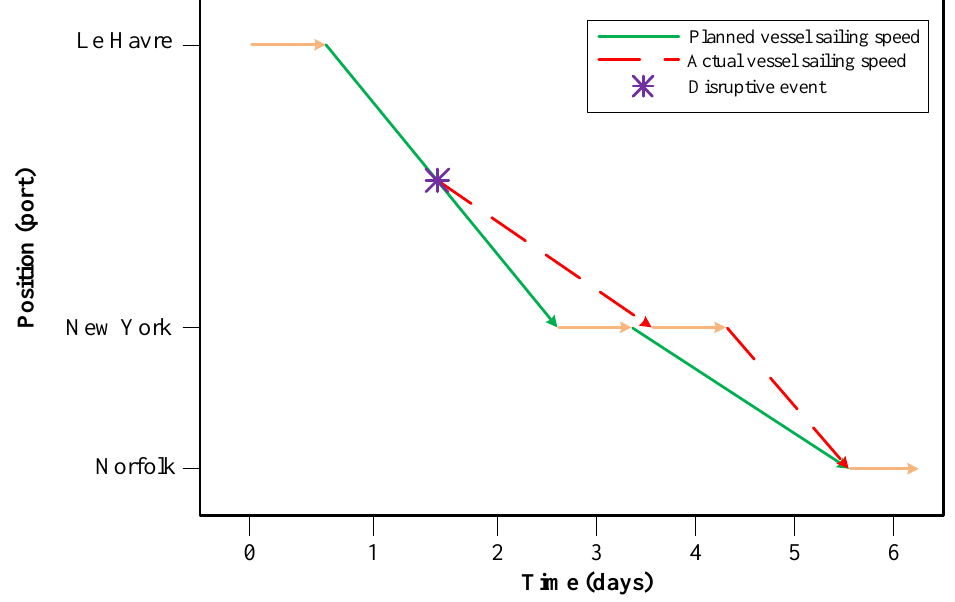
Figure 3. An example of the vessel sailing speed adjustment.